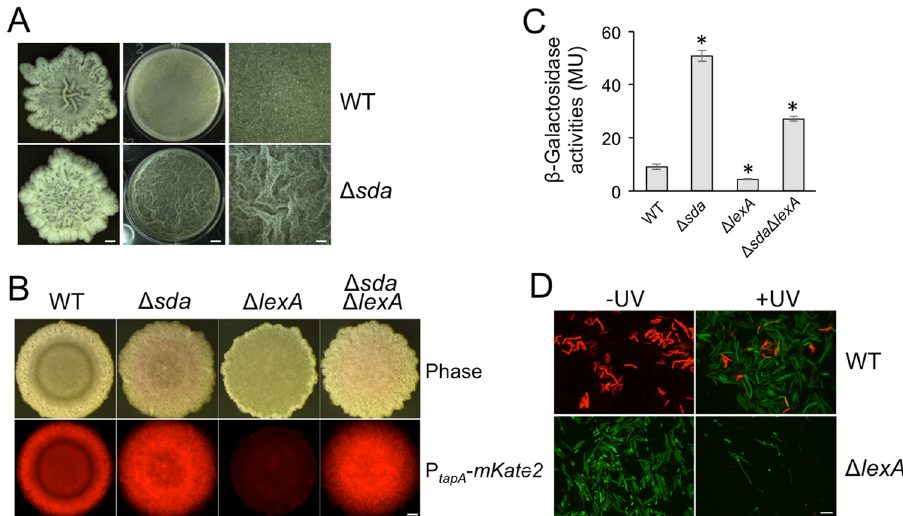
Fig. 3 ROS negatively impacts bio fi lm development through the DDR induction. a The bio fi lm formed by a Δ sda strain is more robust than the isogenic parental strain. Comparison of the bio fi lm (both colony and pellicle) phenotypes between the parental strain (NCIB 3610) and the isogenic Δ sda mutant strain (YCN025). Right-hand panels show zoom-in images of the pellicle bio fi lms shown in the middle panels. Bio fi lms were incubated at 30 °C for 48 h before the images were taken. From left to right , scale bar represents 1, 2.5, and 0.6 mm, respectively. b Matrix gene expression is stronger and more uniform in colony bio fi lms of the Δ sda mutant strains. Colony bio fi lms formed by the wild-type strain, the Δ sda , the Δ lexA , and the Δ sda Δ lexA double mutant strains with the P tapA - mKate2 reporter. Colony bio fi lms were grown on LBGM agar plates at 30 °C for 24 h prior to imaging. Scale bar represents 1 mm. c Quanti fi cation of matrix gene expression. β -Galactosidase activities of the P tapA - lacZ matrix reporter in the wild type, the Δ sda mutant, the Δ lexA mutant, and the Δ sda Δ lexA double mutant strains were assayed in LBGM shaking culture. Assays were performed in triplicate using mid-exponential cells and following published protocols. 25 A two-tailed student ’ s t -test was used to determine statistical signi fi cance between each mutant and the wild-type strain (* indicates p -value < 0.05). d UV treatment triggered DNA damage lowered matrix gene expression. The dual reporter cells (P yneA - gfp , P tapA - mKate2 ) of the wild-type and the Δ lexA mutant strains were treated with UV light, and examined by fl uorescence microscopy after 1 h. Green cells express the DDR P reporter while red cells express the matrix P tapA - mKate2 reporter. Scale bar represents 10 μ